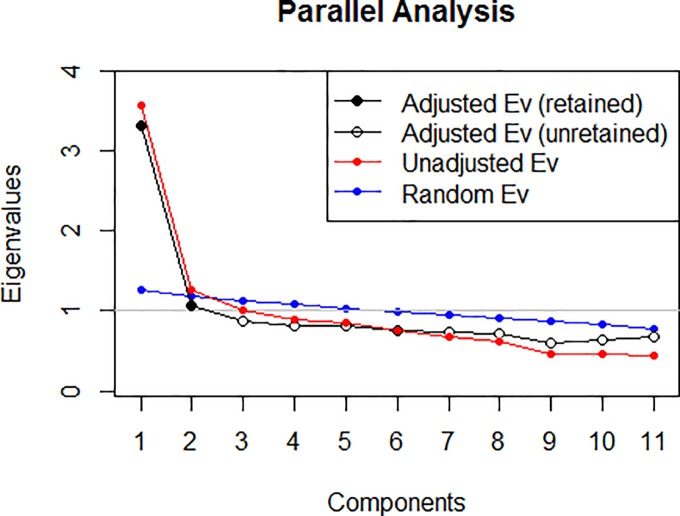
Parallel analysis of the ORTO-11.